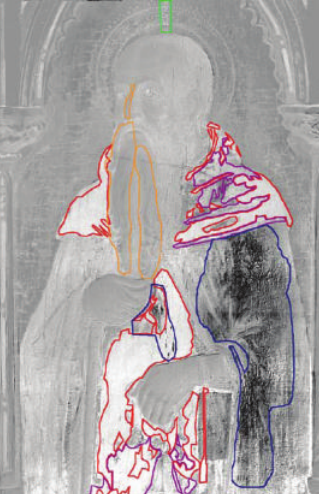
Figure 6: NDI result with additional information and features provided with respect to the visible spectrum (all colours) and to IR2 band, as well (indicated with green, orange and blue colour).